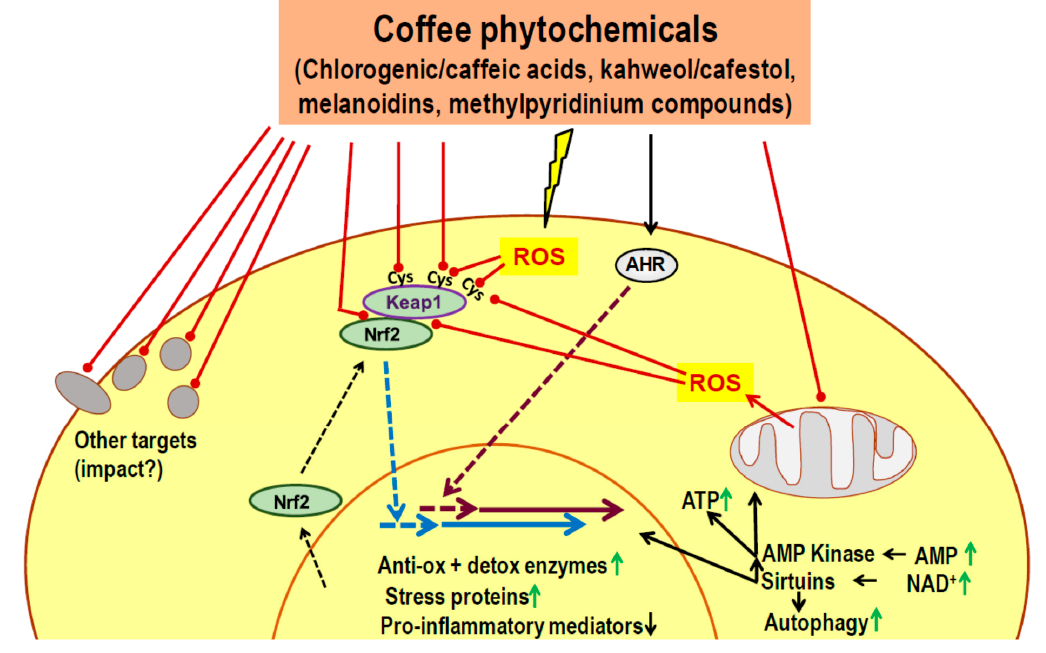
Figure 1. Activation of the nuclear factor erythroid 2-related factor 2 (Nrf2)/Kelch-like ECH-associating protein-1 (Nrf2/Keap1) system and of hydrophobic binding region (AHR) by phytochemicals in roasted (decaffeinated) coffee. Major coffee constituents exhibit binding properties to a number of cellular targets. Consistent physiological responses are elicited by direct (electrophilic) binding to cysteine residues of Keap1 and to AHR, causing the translocation of Nrf2 and AHR, respectively, to the nucleus and the increased expression of genes involved in cell protective activities. Furthermore, there is increased production of reactive oxygen species (ROS), either directly generated from reactive phenolics or indirectly via perturbation of mitochondrial function. Cysteine residues of Keap1 act as sensors of oxidative stress. The resulting modification of Keap1 allows Nrf2 to translocate to the nucleus. Cell stress may result in a lower energy level and increased concentrations of adenosine monophosphate (AMP) and (nicotinamide adenine dinucleotide) NAD + which causes the activation of AMP-activated kinase and of sirtuins, respectively. AMPK lowers anabolic and increases catabolic activities for increasing (adenosine triphosphate) ATP levels. Sirtuins deacetylate histones and other targets leading to improved mitochondrial function, increased autophagy and the expression of genes mediating improved cell survival during periods of stress. ↑ , upregulation; ↓